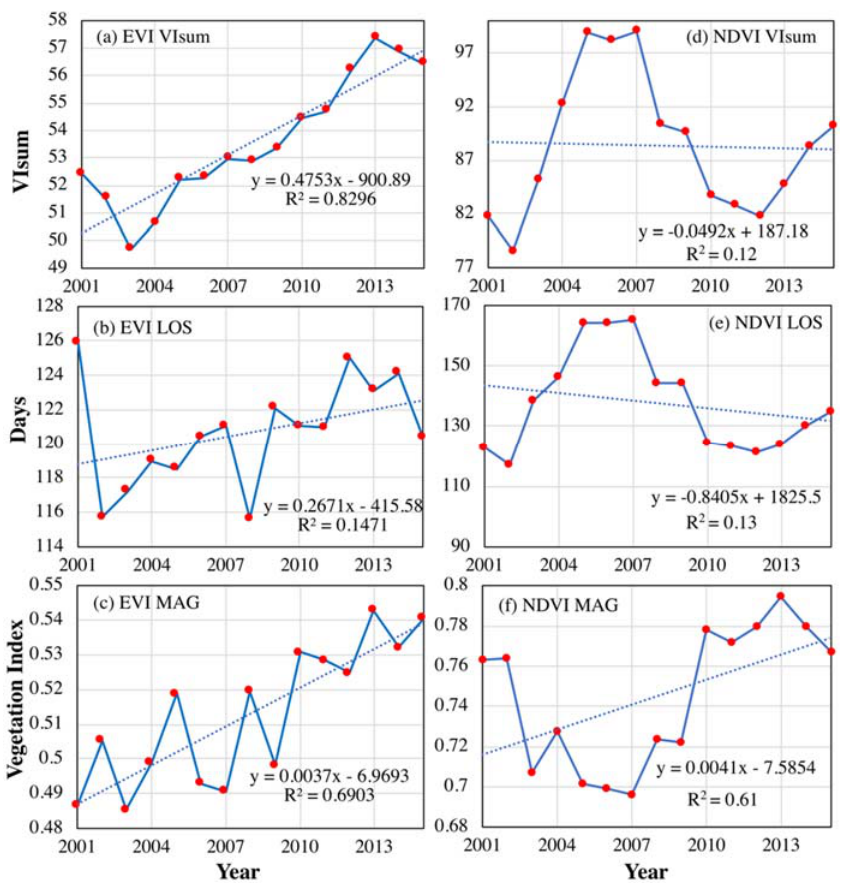
Figure 10. Temporal variations of VIsum, LOS and MAG (in rows) derived from MODIS EVI ( a – c ) and NDVI3g ( d – f ). ( a – c ) is VIsum, LOS and MAG from MODIS EVI, respectively. ( d – f ) is VIsum, LOS and MAG from NDVI3g, respectively.